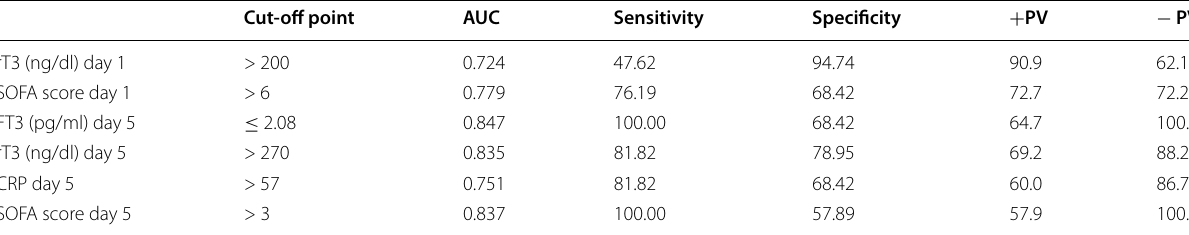
Table 8 Value of indicators in predicting PICU mortality